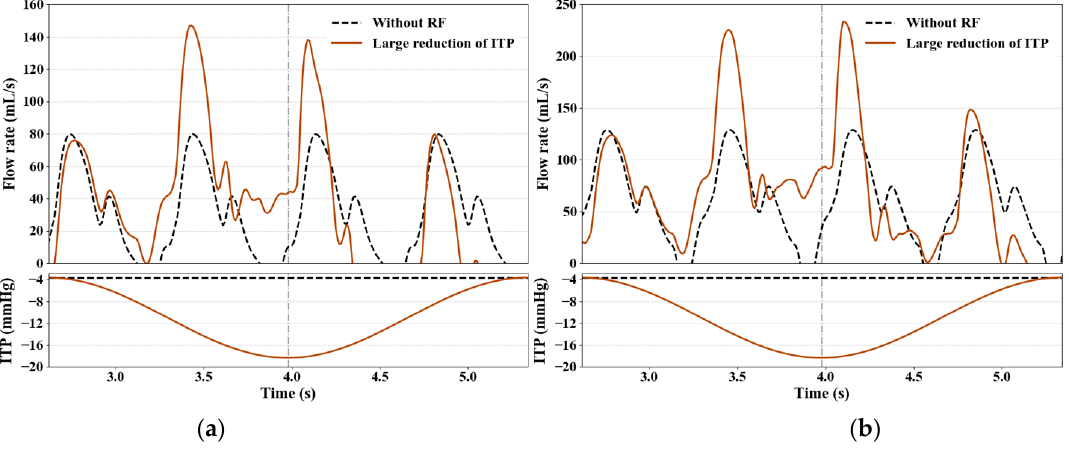
Figure 9. Impact of large ITP reduction on flow rates in SVC ( a ) and IVC ( b ) associated with an adolescent subject.